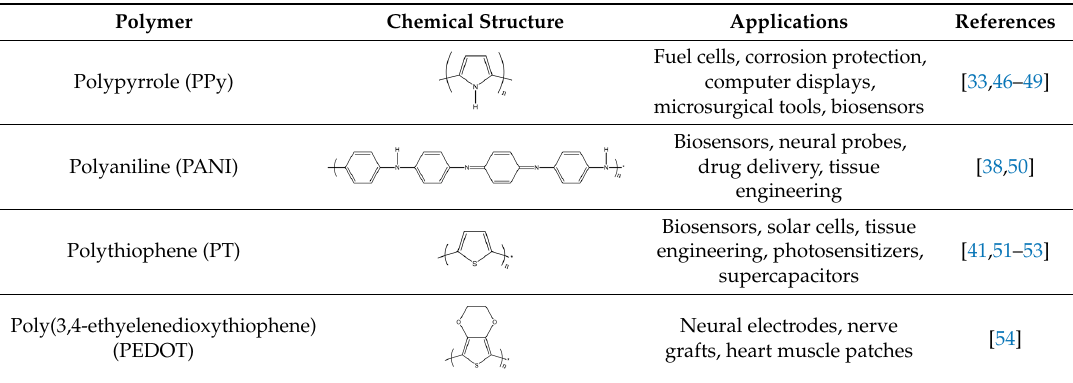
Table 1. Chemical structures, applications of common aromatic Conducting polymers (CPs): Polypyrrole (PPy), Polyaniline (PANI), Polythiophene (PT), and Poly(3,4-ethyelenedioxythiophene) (PEDOT).